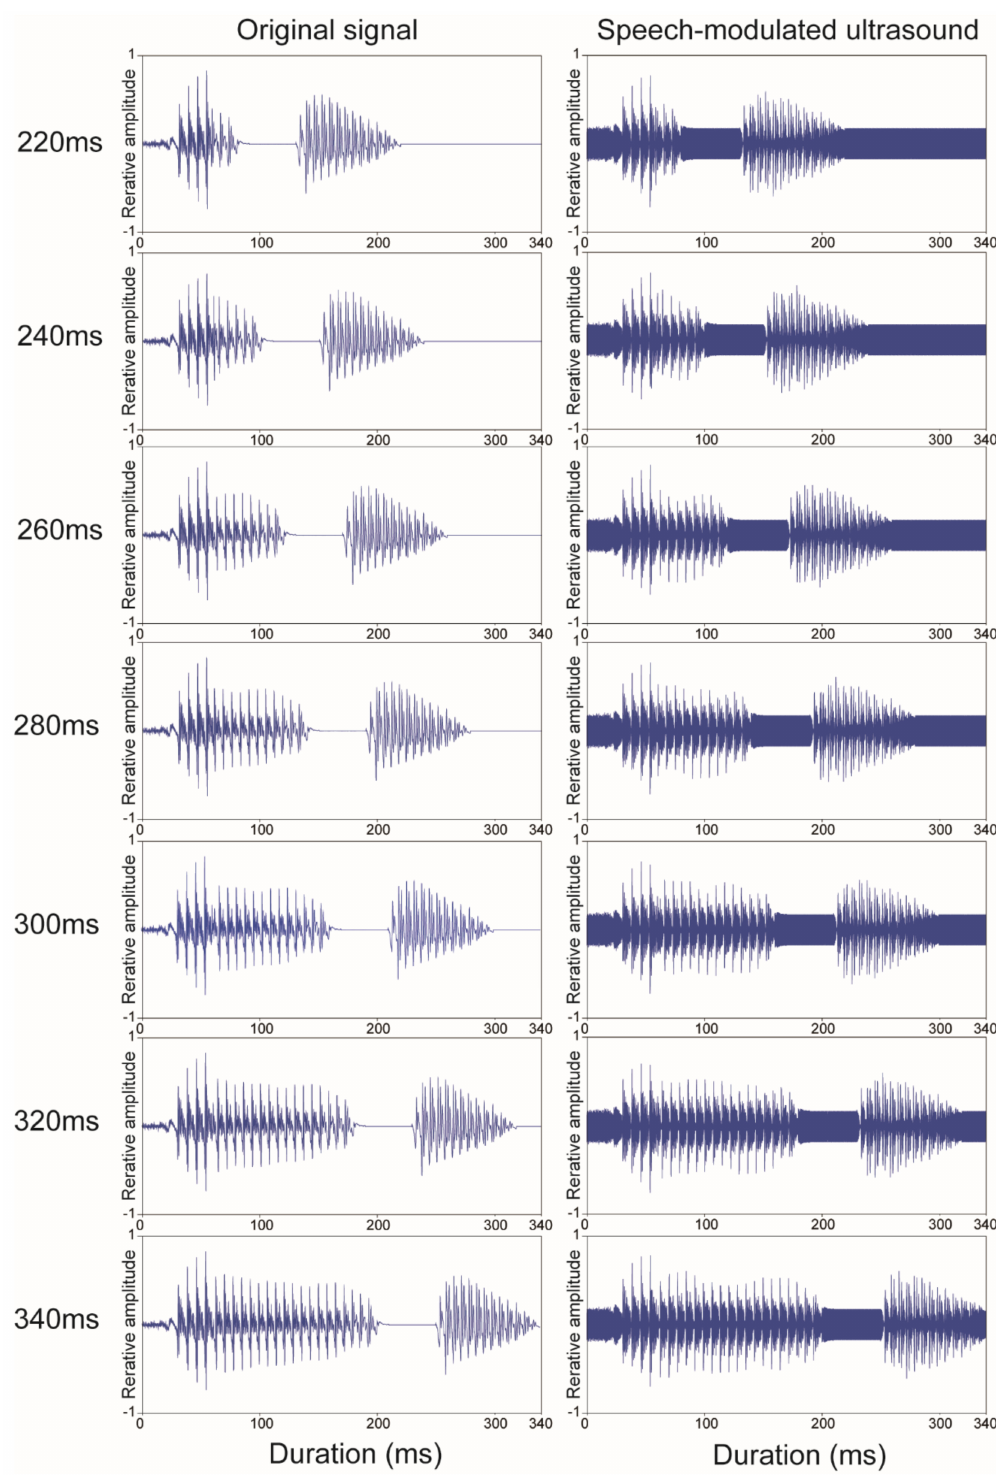
Figure 1. Speech signal waveforms of the original speech and the speech-modulated ultrasonic